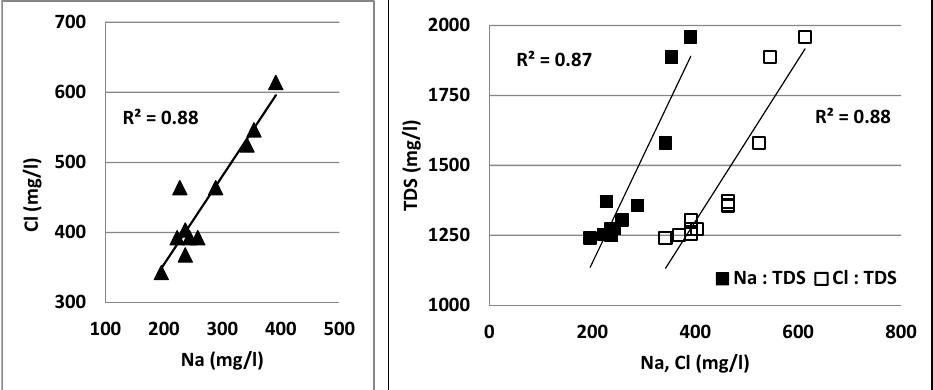
Figure 5. Correlation between Na and Cl (left) and Na and Cl with TDS (right).